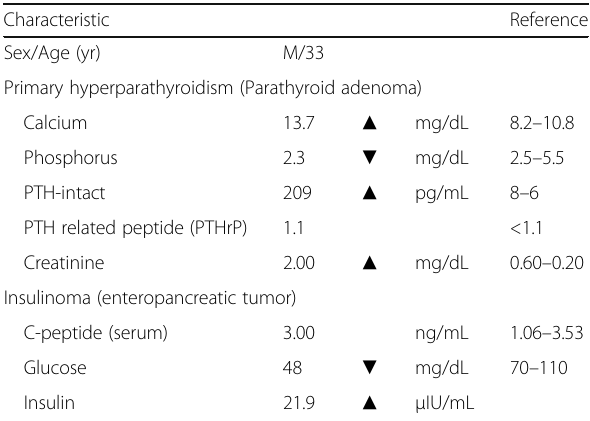
Table 1 Clinical details of the patient with multiple endocrine neoplasia type1 Characteristic